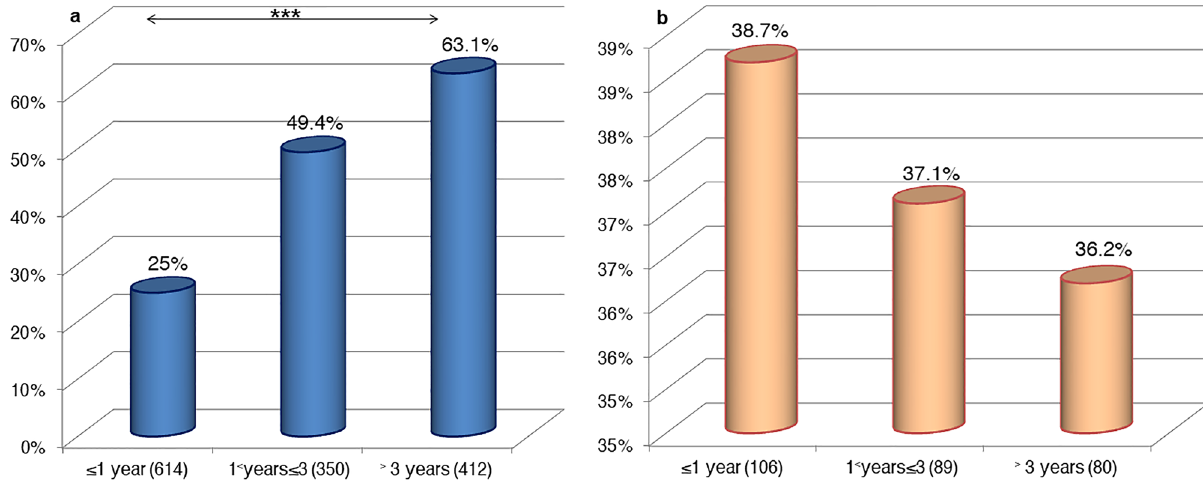
Figure 1. BTV antibody detection results by age in sheep and goats during March 2018–July 2021 in Morocco. ( a ) In sheep. ( b ) In goats (in brackets, the number of samples screened). The statistical significance between rates is indicated as ***P <